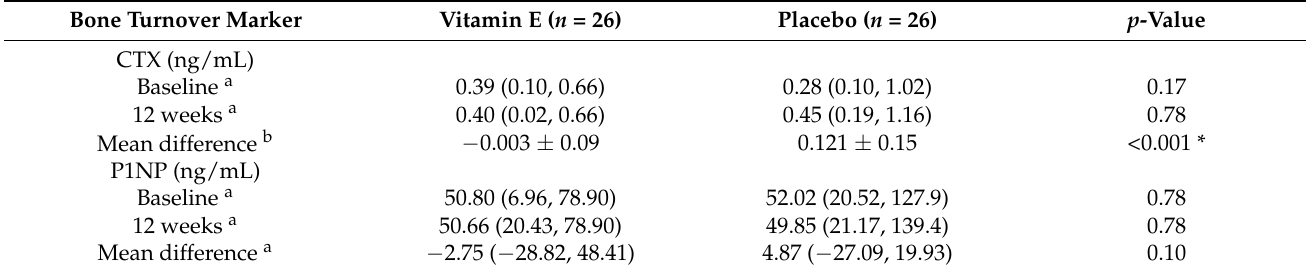
Figure 2 . The bone formation markers in both groups were not significantly changed . Table 2. Comparison of the bone turnover marker between the vitamin E group and placebo group at baseline and 12 weeks .